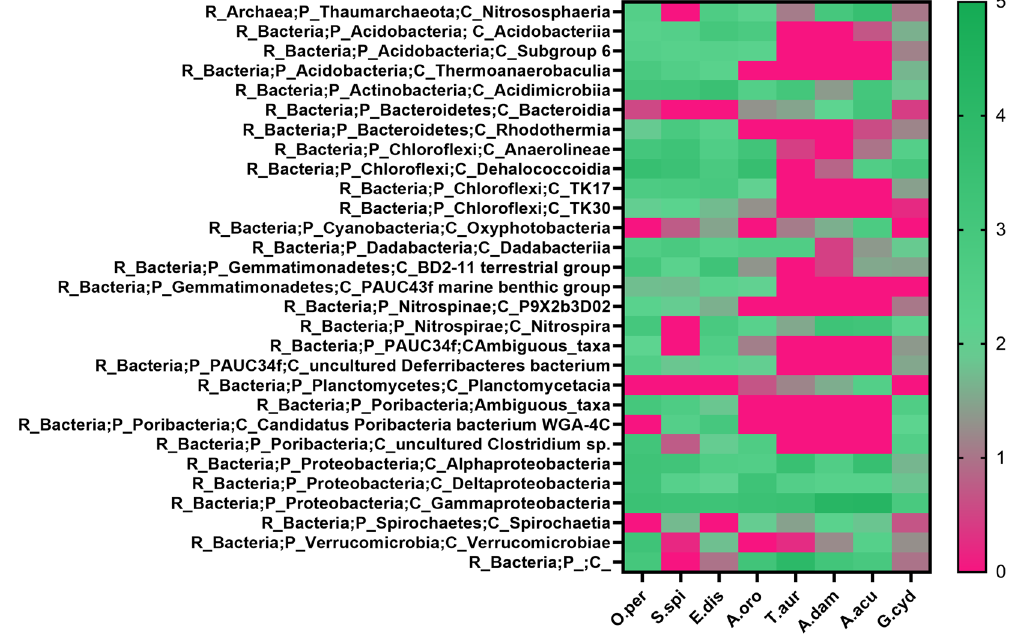
Figure 3. Heat-map comparing the abundance of the most representative bacterial classes identified from O. cf. perforata (O.per), S. spinosulus (S.spi), E. discophorus (E.dis), A. oroides (A.oro), T. aurantium (T.aur), A. damicornis (A.dam), A. acuta (A.acu) and G. cydonium (G.cyd). Color code: green = high number of features, pink = low number of features. Taxonomy code: R = regnum, P = phylum, C = class. Heat-map was performed using GraphPad Prism V. 9 (GraphPad Software, San Diego, CA,